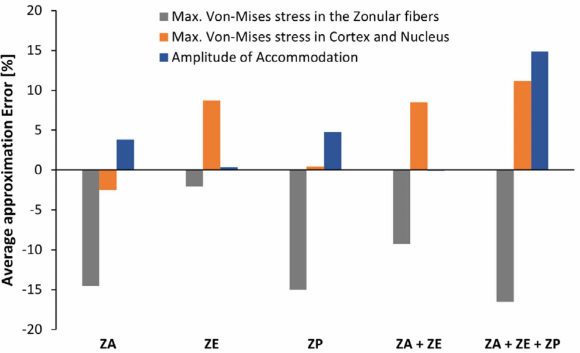
Figure 6. Comparison between superior and inferior values for maximum Von-Mises stress in the zonules, in the lens, and amplitude of